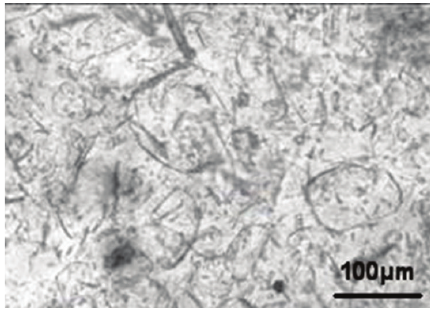
Figure 5: Microphotography of the initial mica sample, series M 0 . Figure 6: Microphotography of the micronized mica sample, series